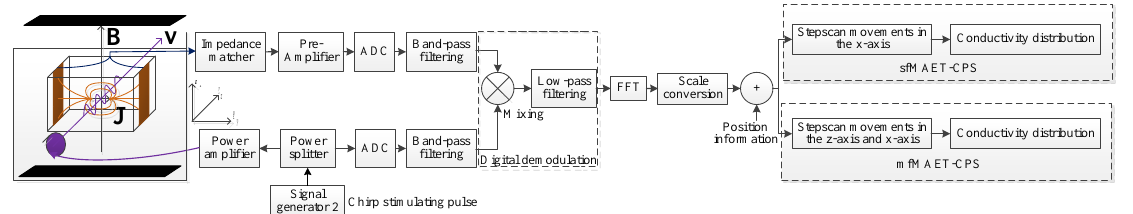
Figure 3. Algorithm flow chart of the single-focus B-scan imaging MAET with chirp pulse stimulation (sfMAET-CPS) and the multifocus imaging MAET with CPS (mfMAET-CPS).